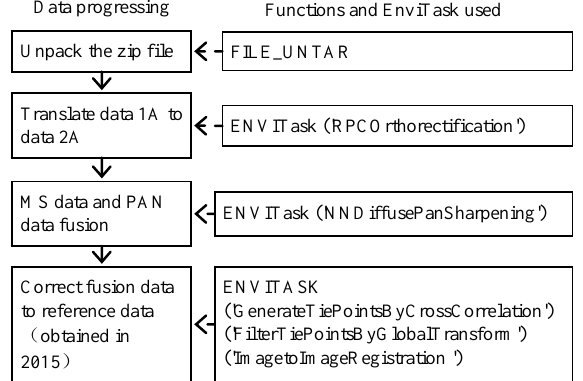
Figure 1. Data batch preprocessing procedure